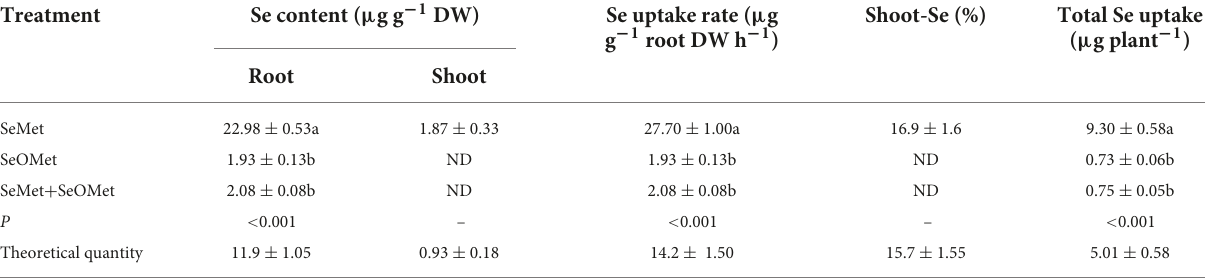
TABLE 3 Effect of SeMet and SeOMet interaction on the uptake and translocation of Se by rice.